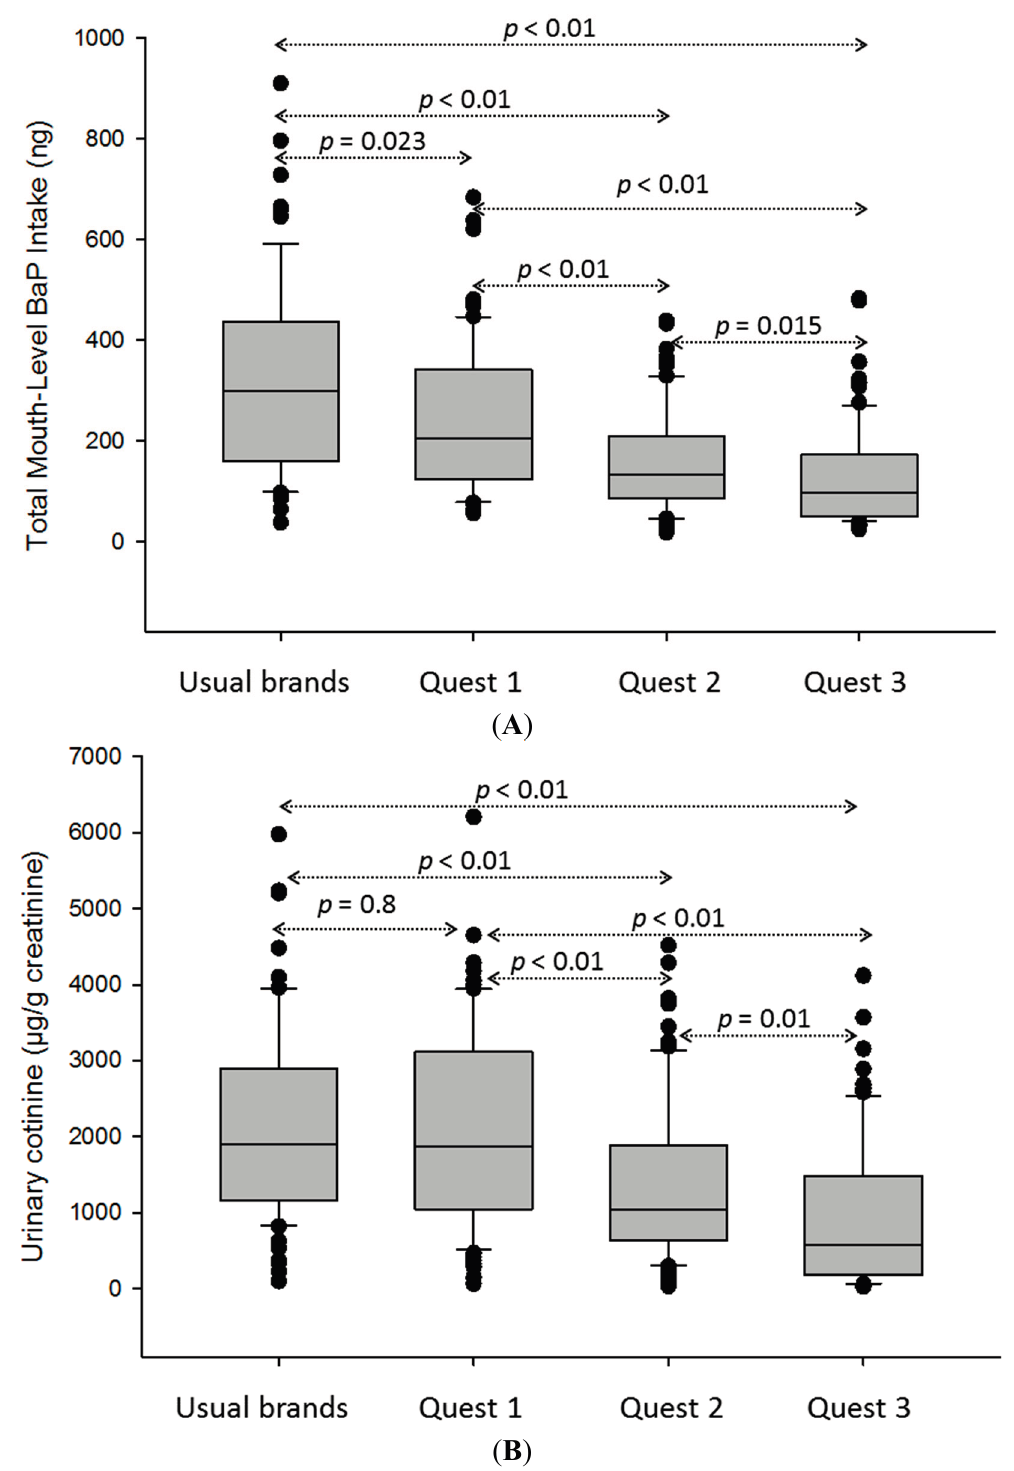
Figure 1. Comparison of daily mouth-level intake of BaP and other biomarkers over the four smoking periods. ( A ) Total mouth-level intake of BaP; ( B ) urinary cotinine; ( C ) urinary 1-hydroxypyrene (1-HOP). Statistically significant values were displayed between each two collection periods for BaP and cotinine. There is no statistical significance between each of the two collection periods for